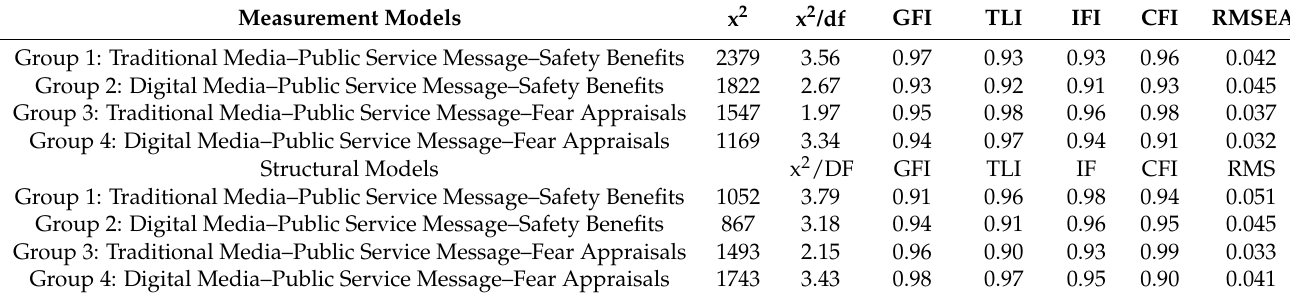
Table 3. Confirmatory Factor Analysis.